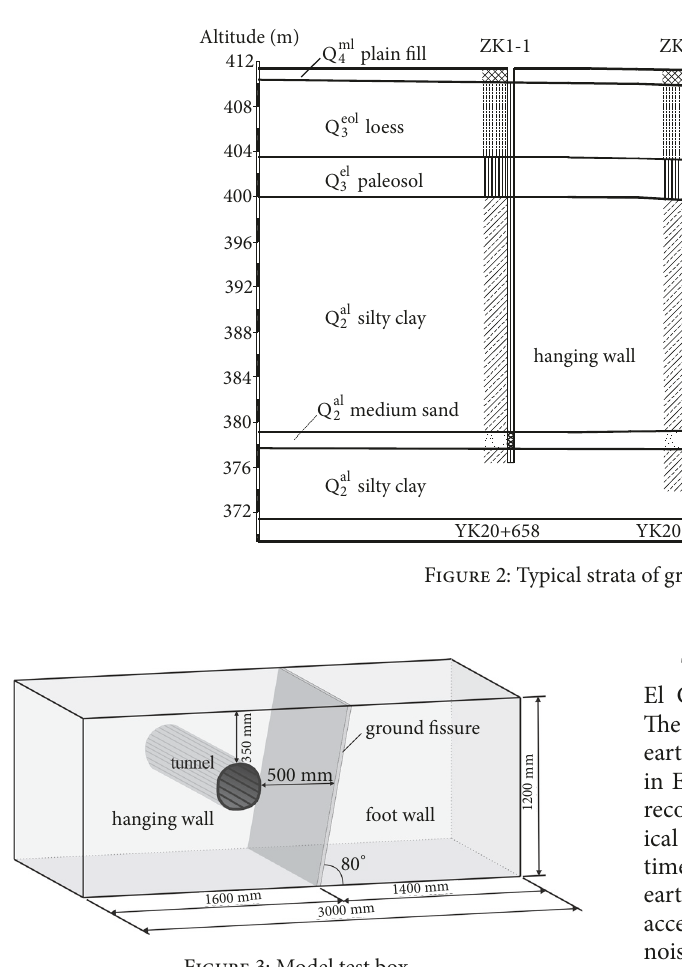
Figure 3: Model test